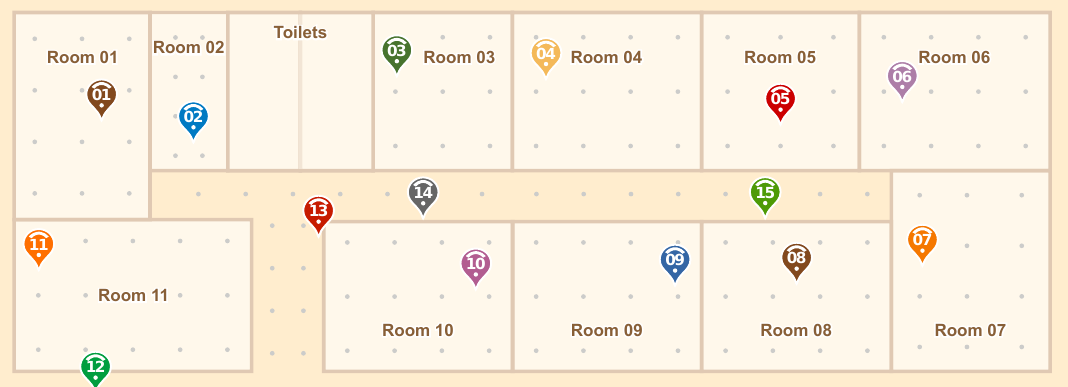
Figure 5. Testbed map: 11 rooms, 3 halls, and 15 anchor nodes. 100 packet samples collected from 150 test points.